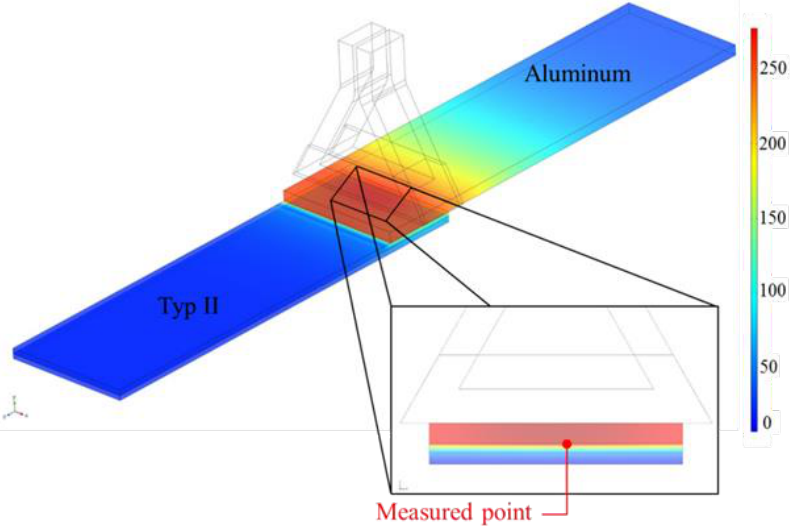
Figure 6. Simulation of the heating temperature of the ICJ process sample II+Al.